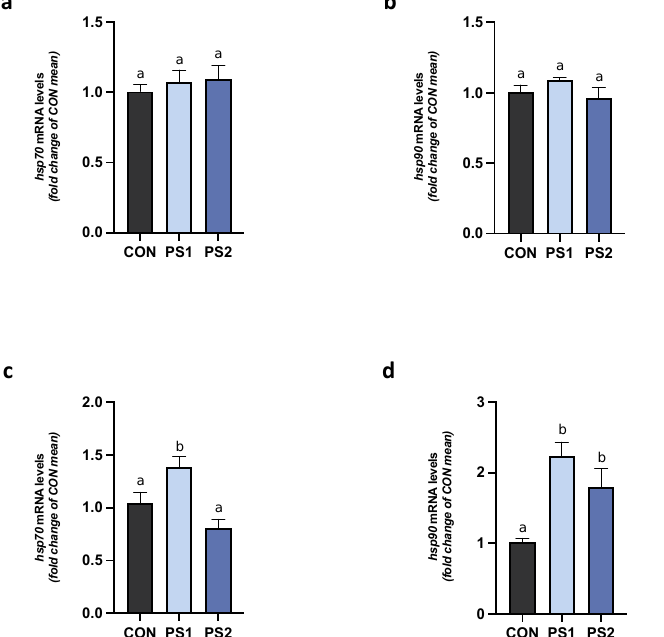
Figure 7. PS-MPs effect on gene expression of heat shock proteins in gut of gilthead seabream. The transcriptional levels of hsp70 and hsp90 were evaluated in ( a , b ) anterior (AI) and ( c , d ) posterior intestines (PI). All data are shown as mean ± S.E.M. Different letters indicate significant differences among treatments (at least p < 0.05).